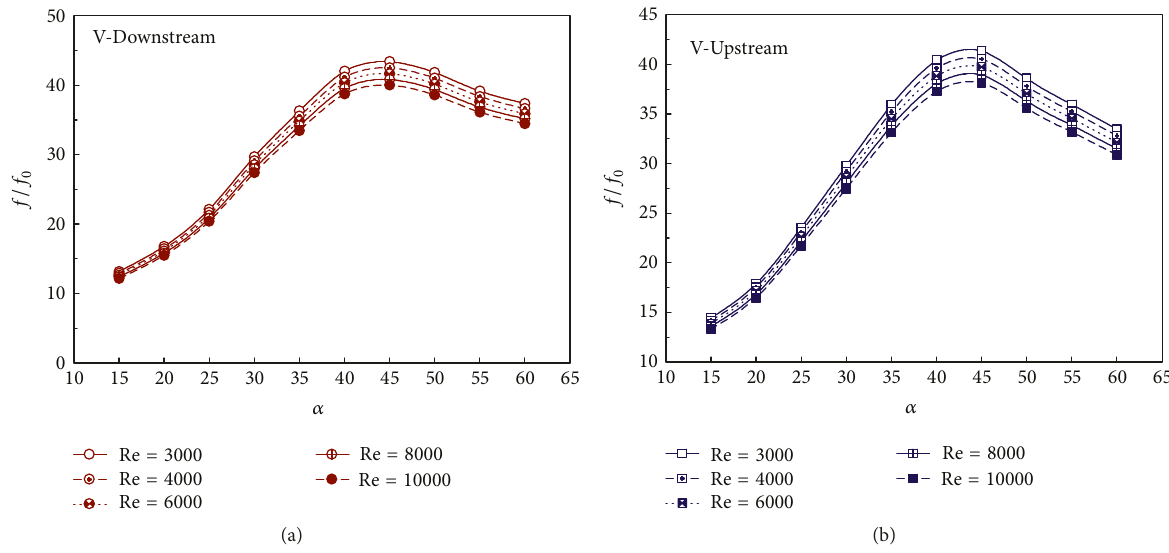
Figure 11: f / 𝑓 0 versus 𝛼 for the square channel inserted with V-wavy plate at various Reynolds numbers of (a) V-Downstream and (b) V- Upstream.